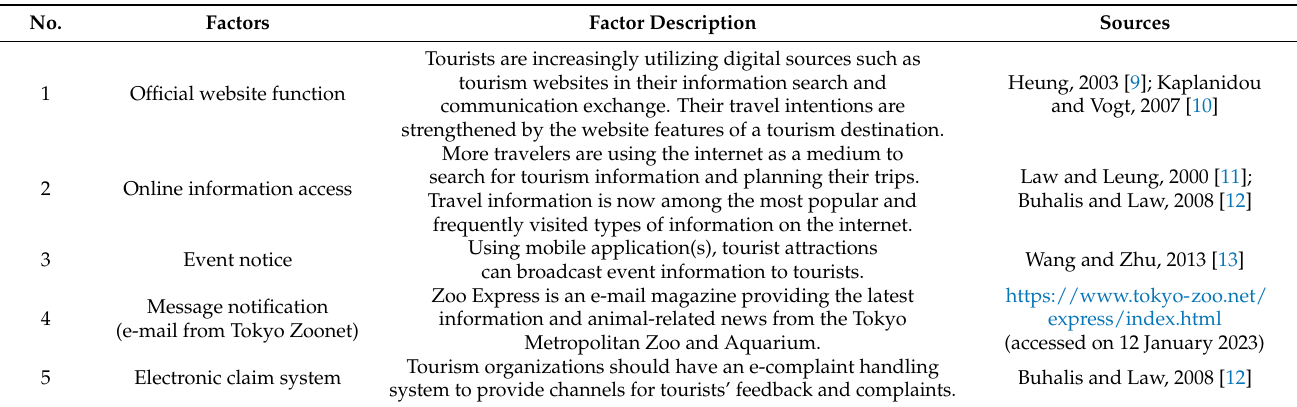
Table 1. The original evaluation items of SZSOJ and